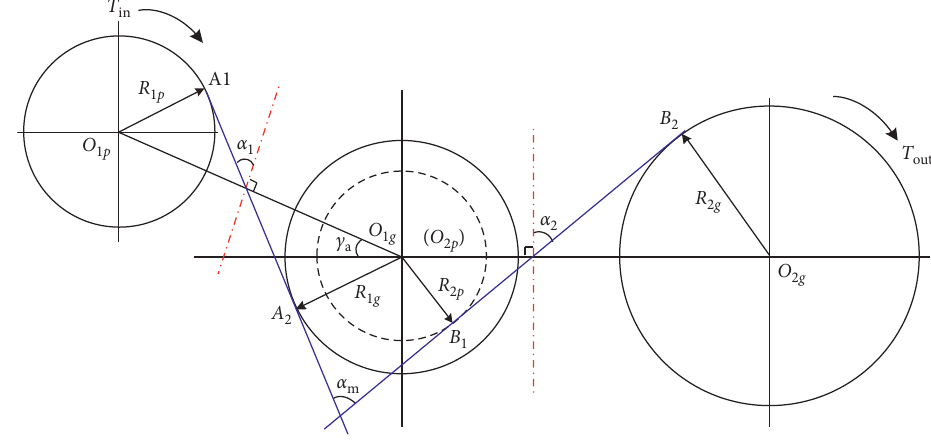
Figure 2: Angle of the two planes of